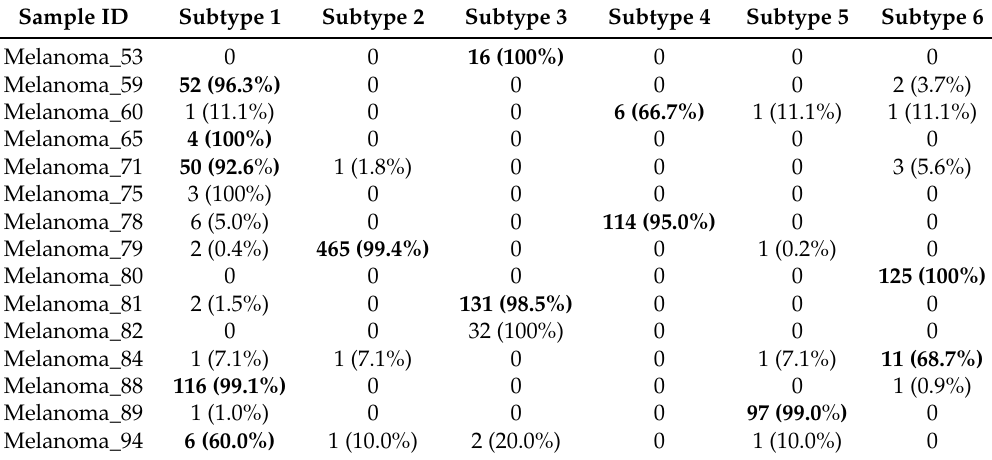
Table 2. Cell subpopulations presented in each sample/patient. The majority of cells belonging to a subtype was highlighted in bold-face